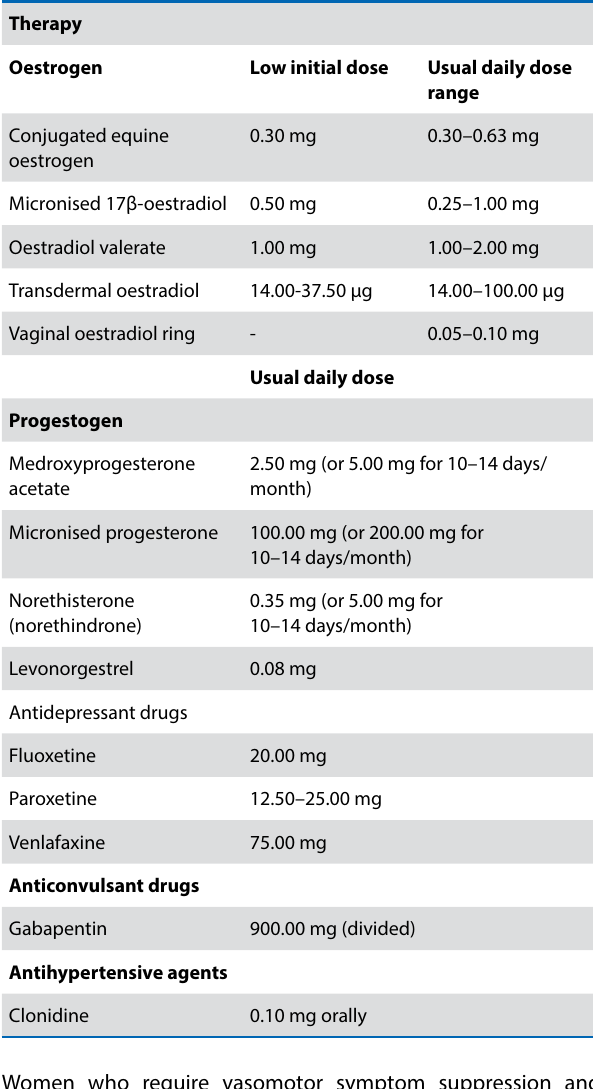
Table 2: Recommended dosing ranges for commonly used oral and transdermal hormonal and non-hormonal therapies used to